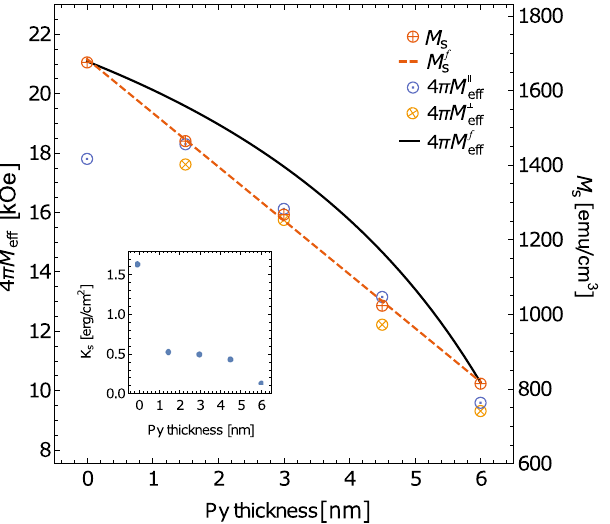
Figure 2. The saturation magnetization M s as determined from SQUID measurements (right axis) and effective saturation induction 4 π M eff as determined by FMR (left axis) for the − d d Py Fe 6 ( ) ( ) scaled by 4 π to right axis for direct comparison. The dashed line represents a linear fit to the M s data using eq. (1) and the solid line is a plot of eq. (2) using = M 817emu/cm sPy 3 and = M 1678emu/cm sFe 3 . The interface anisotropy as extracted from eq. (9) is shown in the